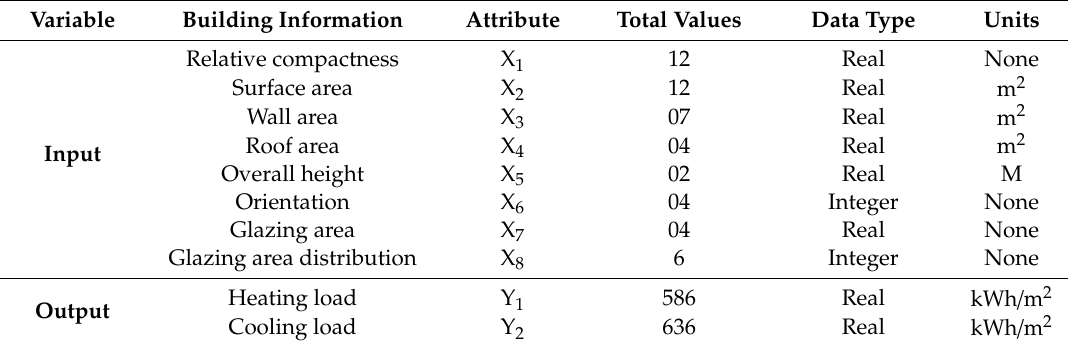
Table 3. Detailed description of energy e ffi ciency